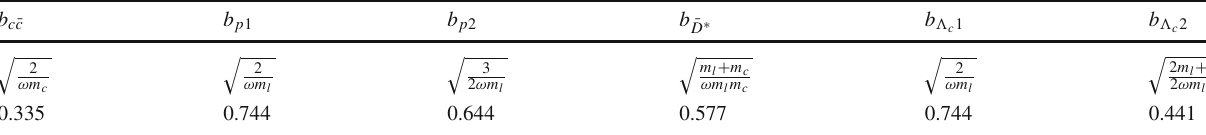
Table 1 The size parameters of final hadrons (in units of fm) with the universal ω = 0 . 45 GeV and the quark mass of m l = 0 . 313 GeV and m c = 1 . 54